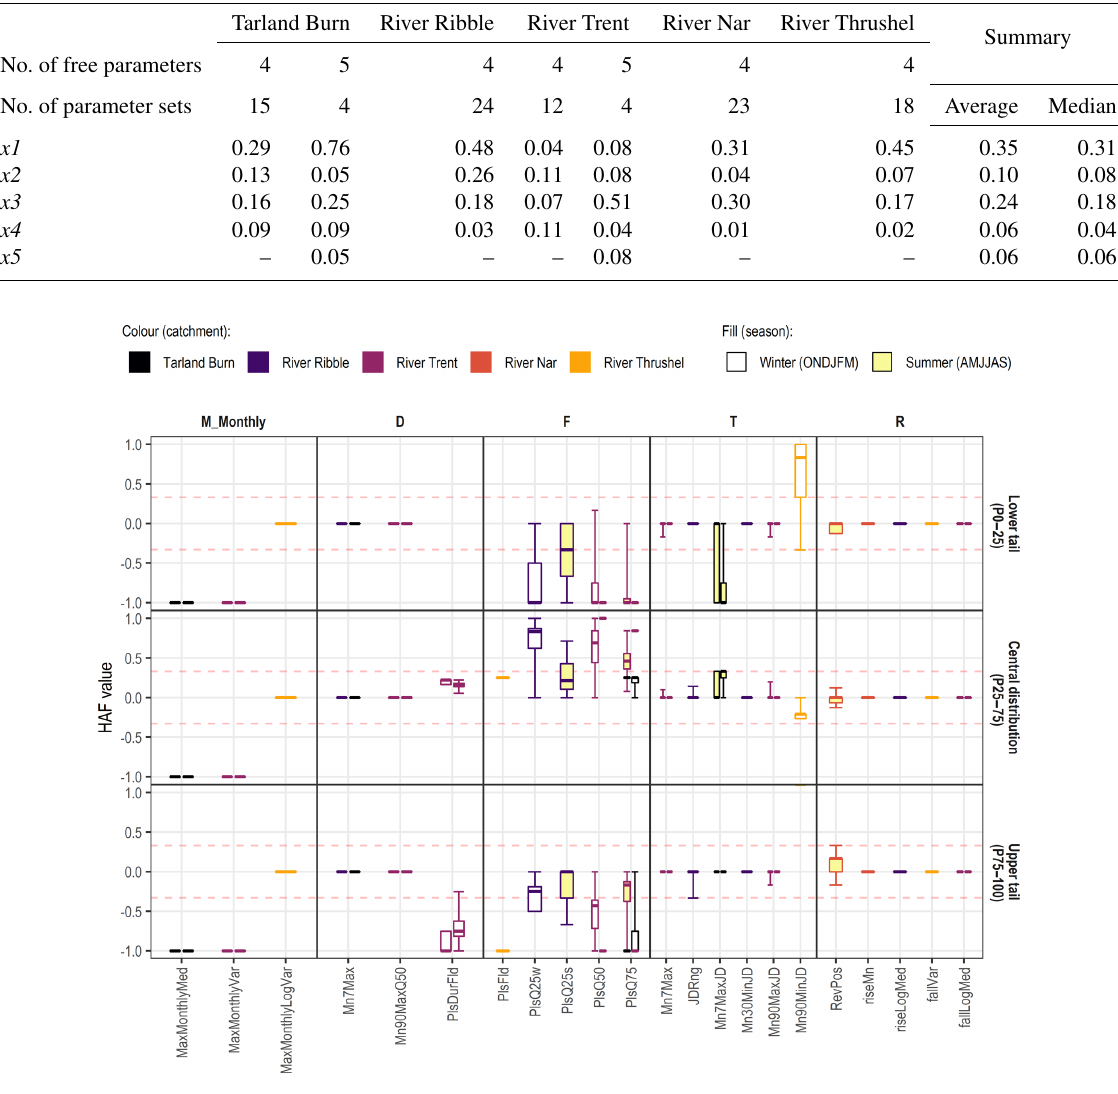
Figure 3. Hydrologic alteration factor (HAF) values for the three percentile ranges for each ER HI; ER HIs are grouped by facet of the flow regime: magnitude ( M ), duration ( D ), frequency ( F ), timing ( T ) and rate of change ( R ). The acceptable range of HAF values is defined as ± 0 . 33 (red dashed line); HAF > 0 represents an increase in frequency relative to that observed, whilst HAF < 0 represents a decrease. All magnitude statistics and ratio ER HIs achieved optimal values (HAF = 0) and are not depicted. The four- and five-parameter results are adjacent, left and right respectively, for the Tarland Burn and River